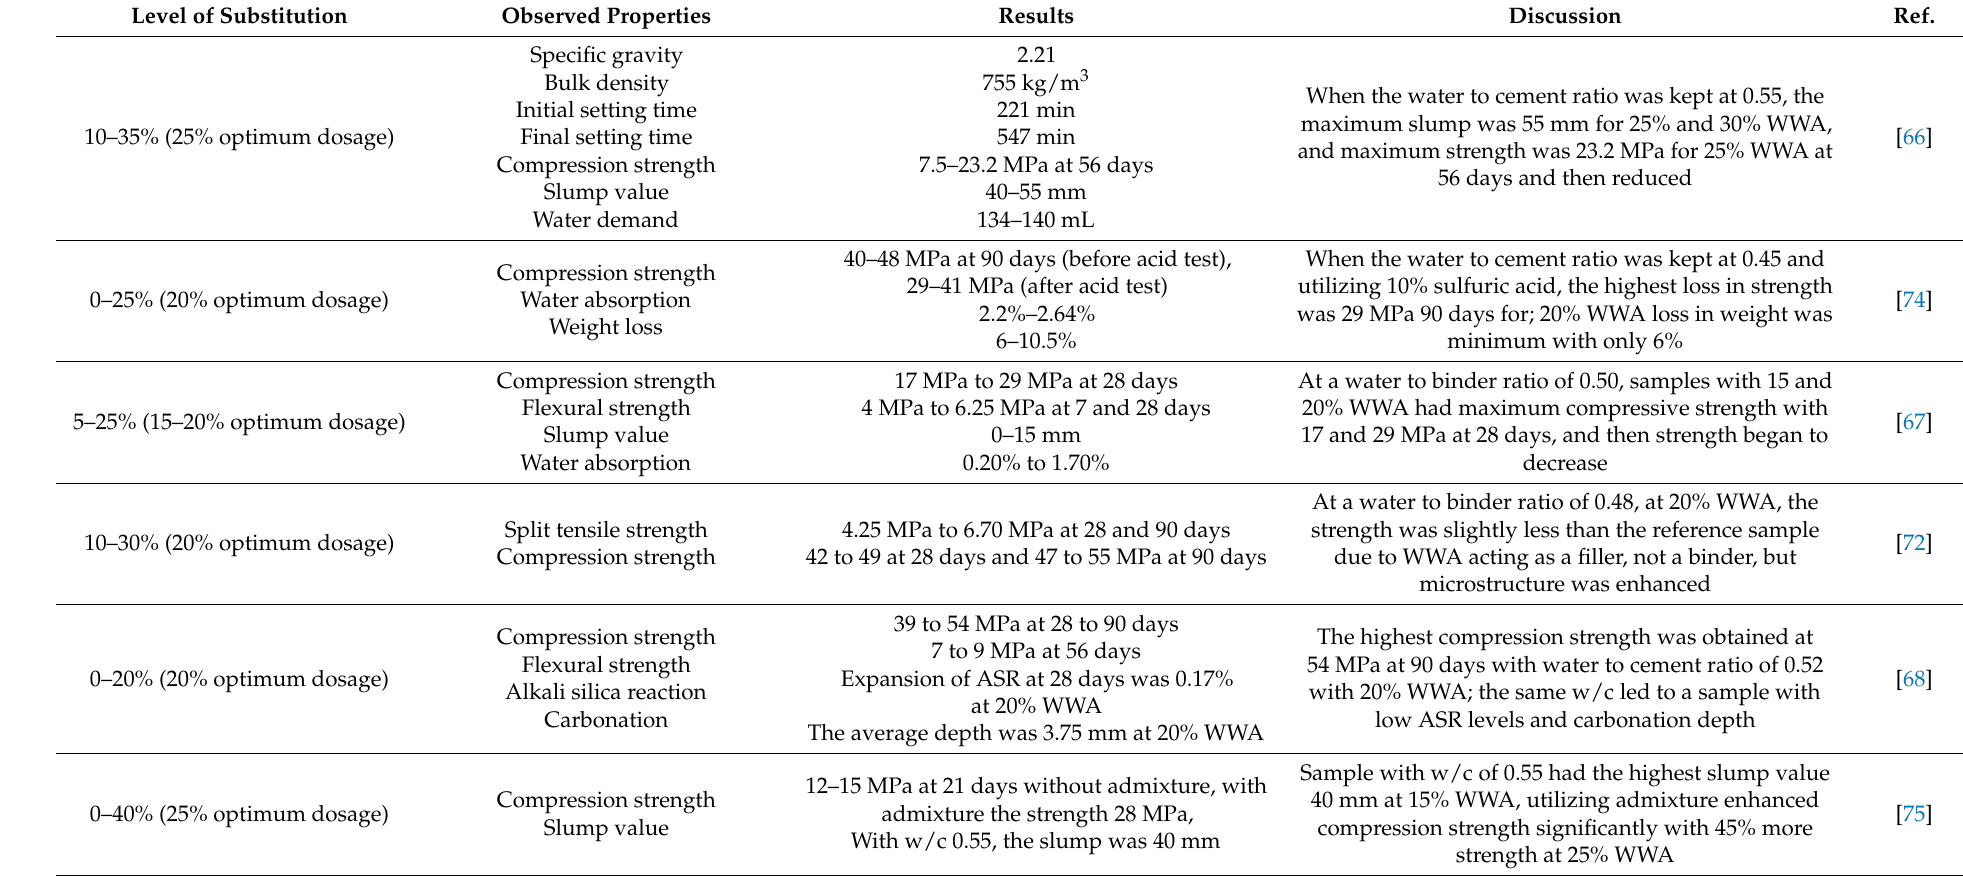
Table 3. Influence of waste wood ash on the characteristics of